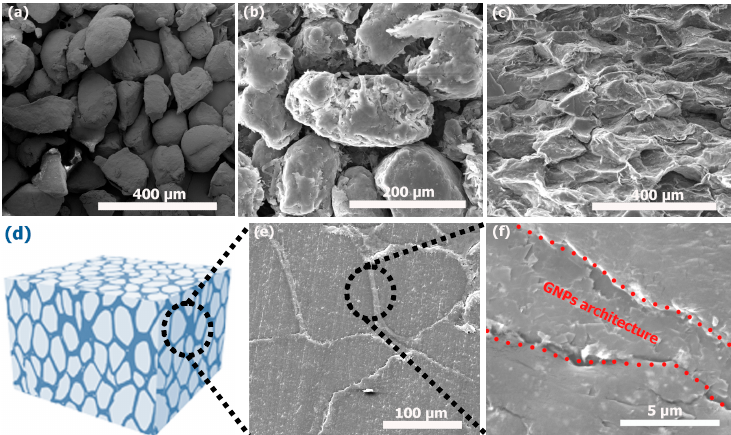
Figure 2. SEM images of ( a ) neat PP ( b ) GNPs-coated PP ( c ) the section view of before polishing hot pressed composite ( d ) scheme of composite ( e ) after polishing the surface ( f ) the magnification of ( e ).